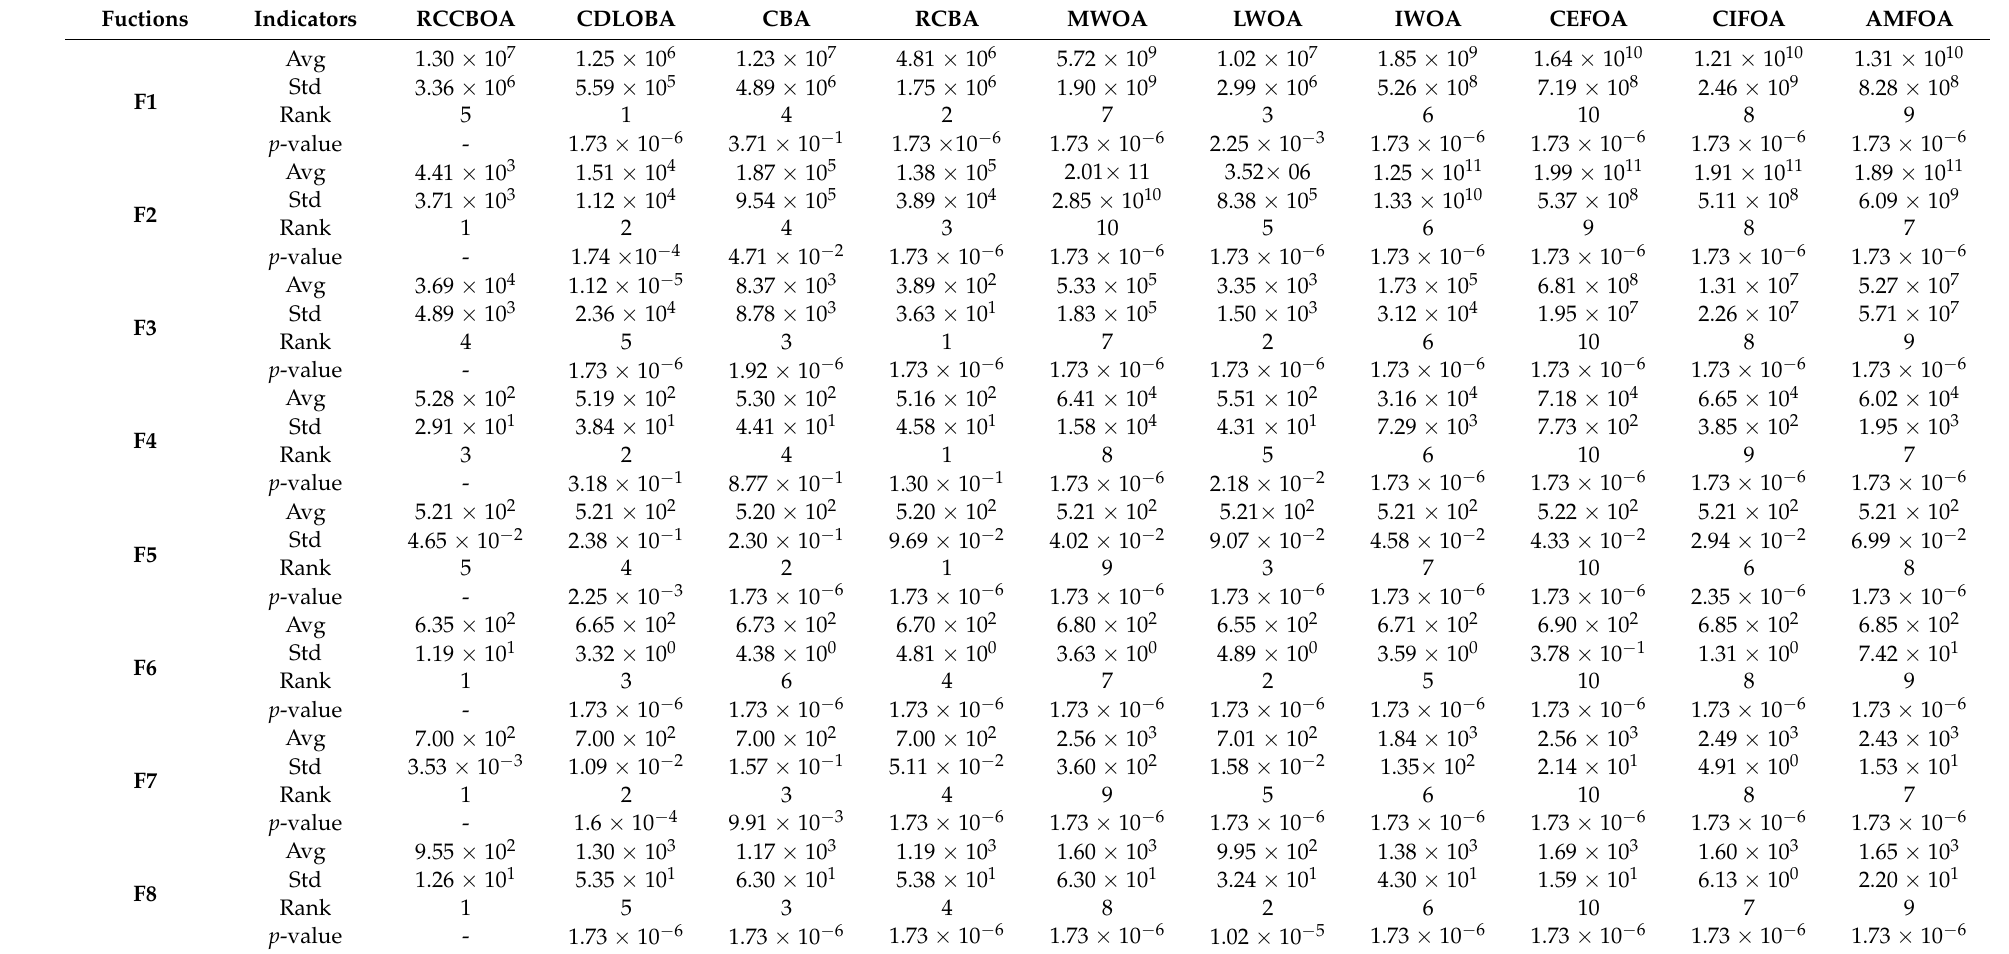
Table 6. Comparison of the results of the RCCBOA and different advanced